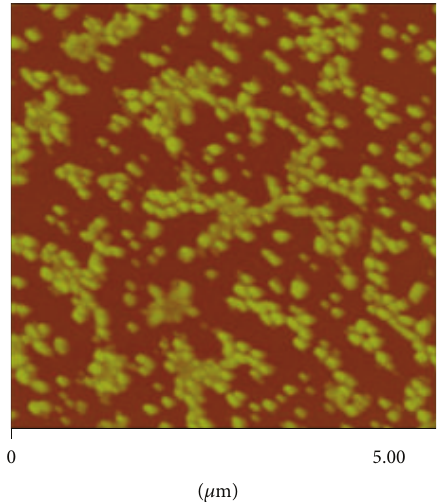
Figure 9: AFM photo of DPG after high-temperature aging. The scanned area is 5 × 5 𝜇